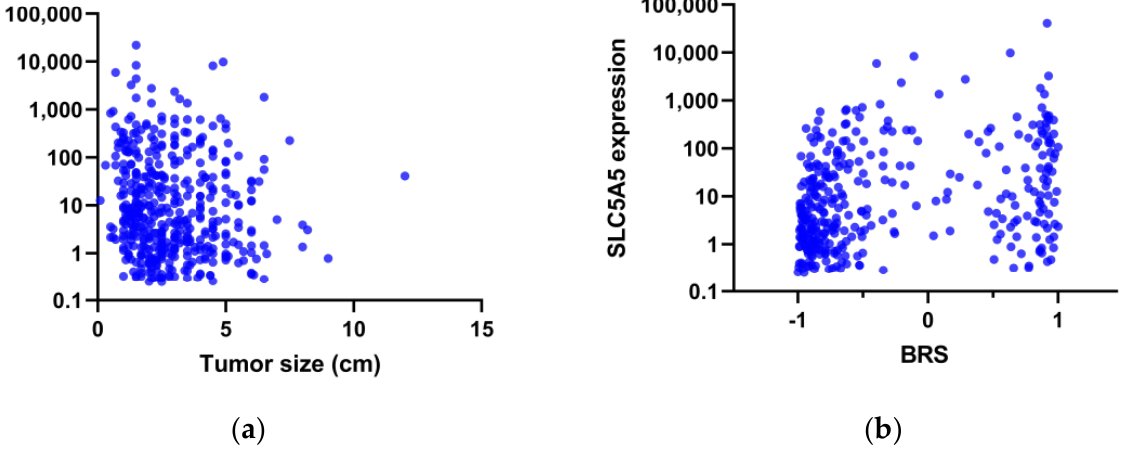
Figure 1. Scatter plots of the expression of SLC5A5 (sodium iodide symporter) versus ( a ) tumor size and ( b ) BRAF-RAS scores (BRS) in the TCGA-THCA dataset. Data are expressed as the number (percentage) or median (interquartile